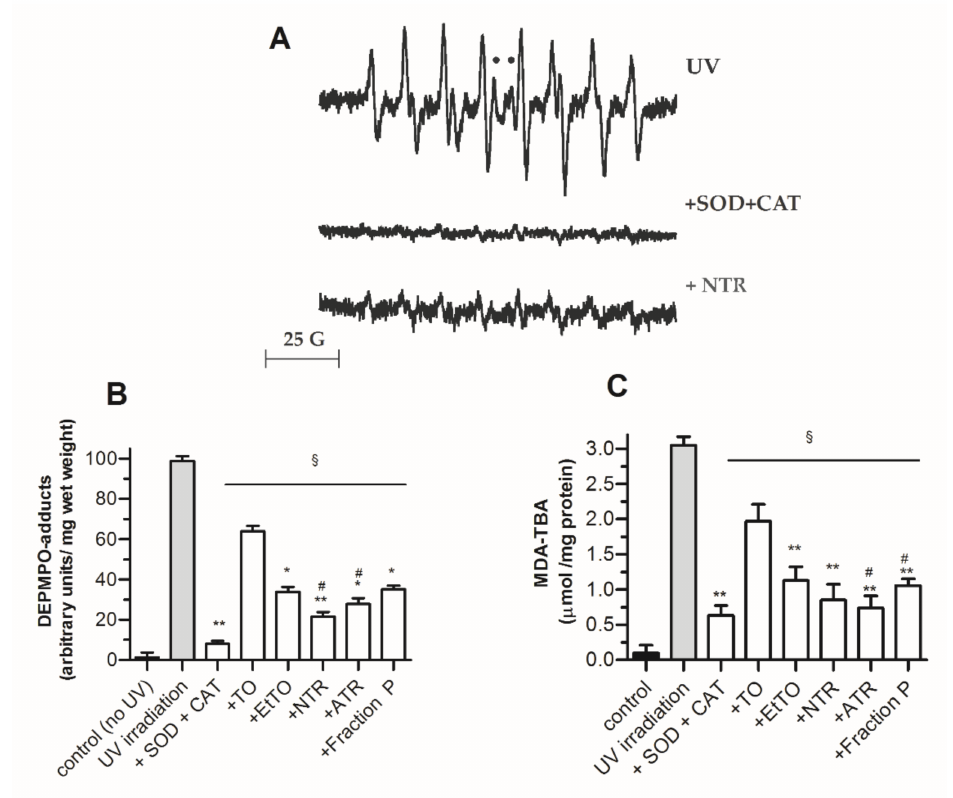
Figure 4. Protective effect of TO extracts and metabolites against UV irradiation (1 h)-induced damage in rat skin slices. ( A ) Typical electron paramagnetic resonance (EPR) signals of mixtures of DEPMPO-OOH + DEPMPO-OH in the supernatants of post-irradiated skin slices incubated